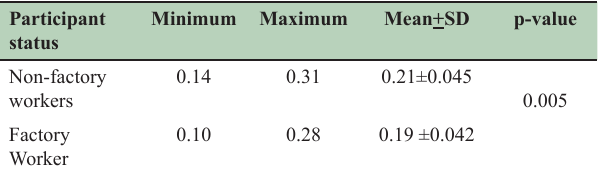
*All figures in bold indicate the maximum percentage of the characteristic, for example 46.9 (47%) of all Factory workers had black hair. Table-IV: Medullary index of